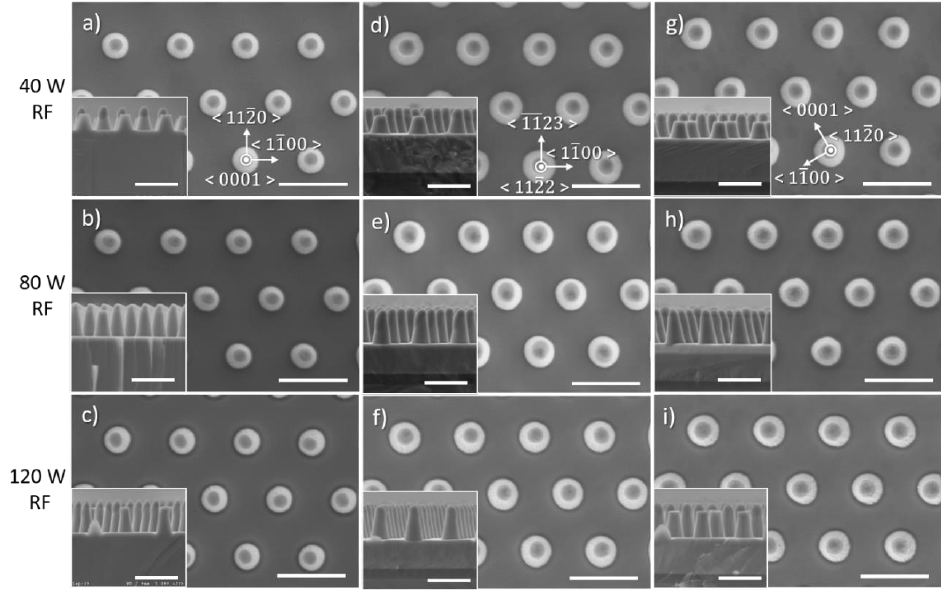
Figure 9. Plan view and cross-sectional (inset) SEM image of GaN nanorod etch series 5 with different radio-frequency (RF) powers for ( a – c ) c -plane ( d – f ) (11 2̅2 ) semi-polar and ( g – i ) (11 2̅0 ) non-polar GaN radio-frequency (RF) powers for ( a – c ) c -plane ( d – f ) (1122) semi-polar and ( g – i ) (1120) non-polar layers. Scale bar is 1 µm. GaN layers. Scale bar is 1 µ